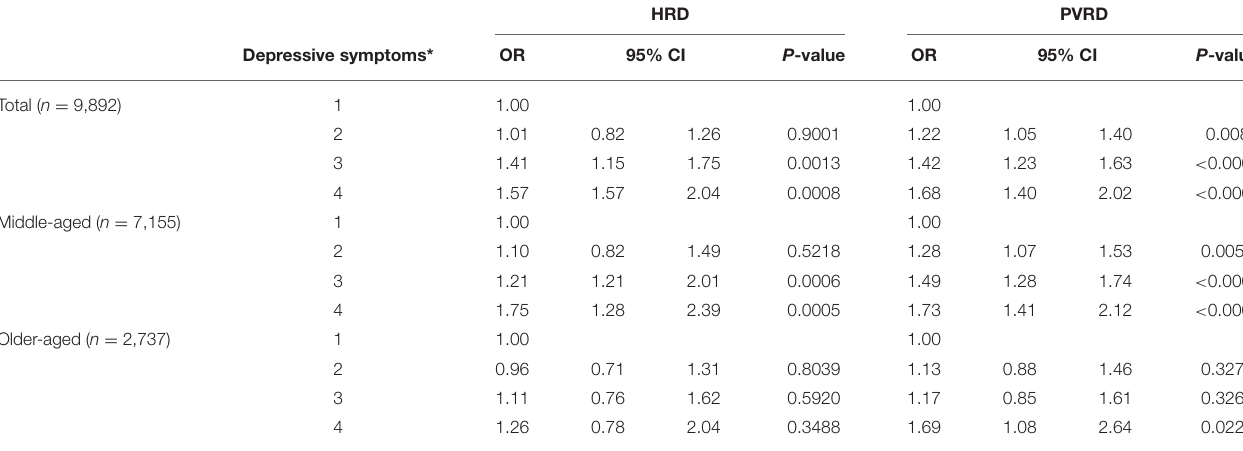
TABLE 3 | Main effects associations between depressive symptoms and CVDs.